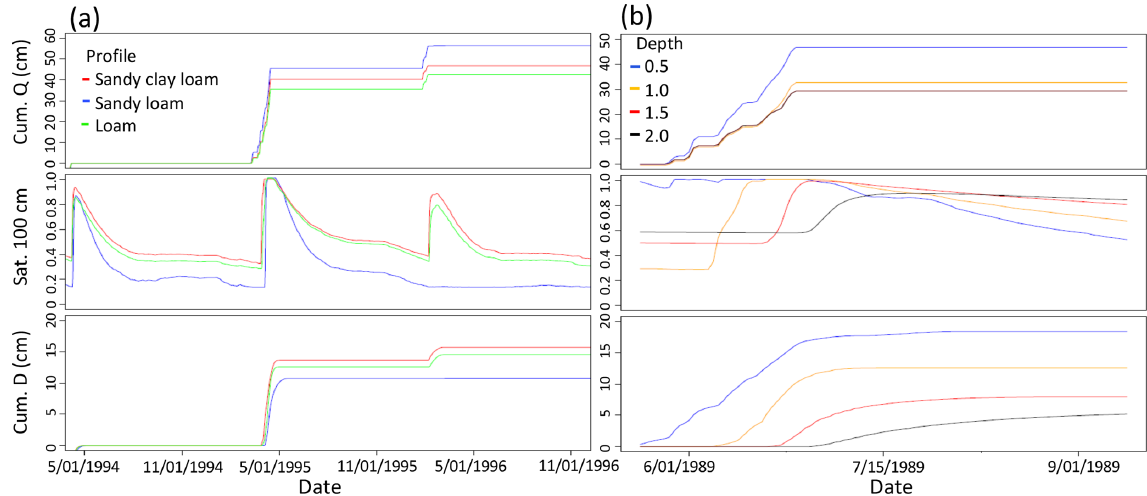
Figure 8. (a) Daily time series of cumulative runoff ( Q ), saturation at 100cm depth (Sat 100 ), and cumulative deep drainage ( D ) for SNOTEL site 698 input on SNOTEL site 515 (sandy loam), 1049 (sandy clay loam), and 1056 (loam) profiles. (b) Daily series for the same variables plotted for four depth scenarios 0 . 5 × , 1 × , 1 . 5 × , and 2 × original rooting zone depth.